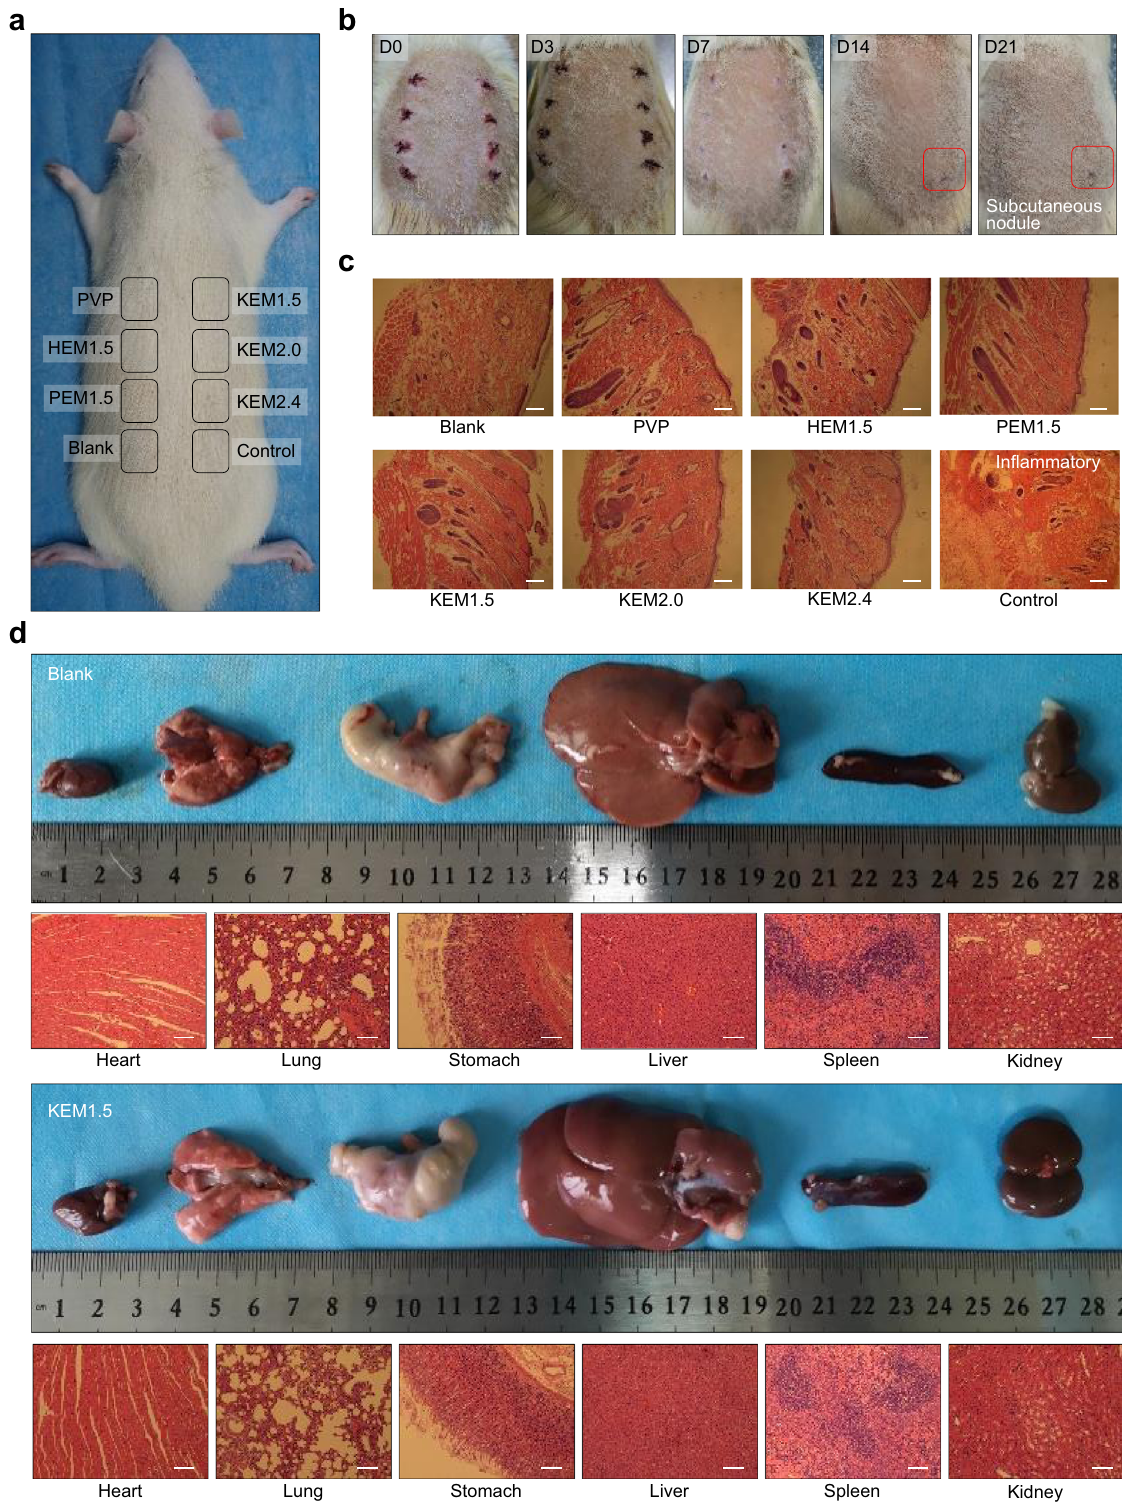
Fig. 5 Biological toxicity evaluation. a Photograph for the wound regions in back embedding model. b Photographs of the wounds that were embedded the PVPEM, HEM 1.5 , PEM 1.5 , KEM 1.5 , KEM 2.0 , KEM 2.4 , control group and blank group samples immediately following surgery (day 0), and for 3, 7, 14, 21 day. c Histological analysis of subcutaneous tissue of the wounds after embedding surgery. Scale bar, 200 µ m. d Photographs and histological analysis for rat internal organs (heart, lung, stomach, liver, spleen and kidney) after 21 days embedding experiment with KEM 1.5 and blank group, respectively. Scale bar, 100 µ m. Data were analyzed from at least three independently experiments in ( c ) and ( d ). All experiments were replicated at least three times independently with similar results. Source data are provided as a Source Data fi